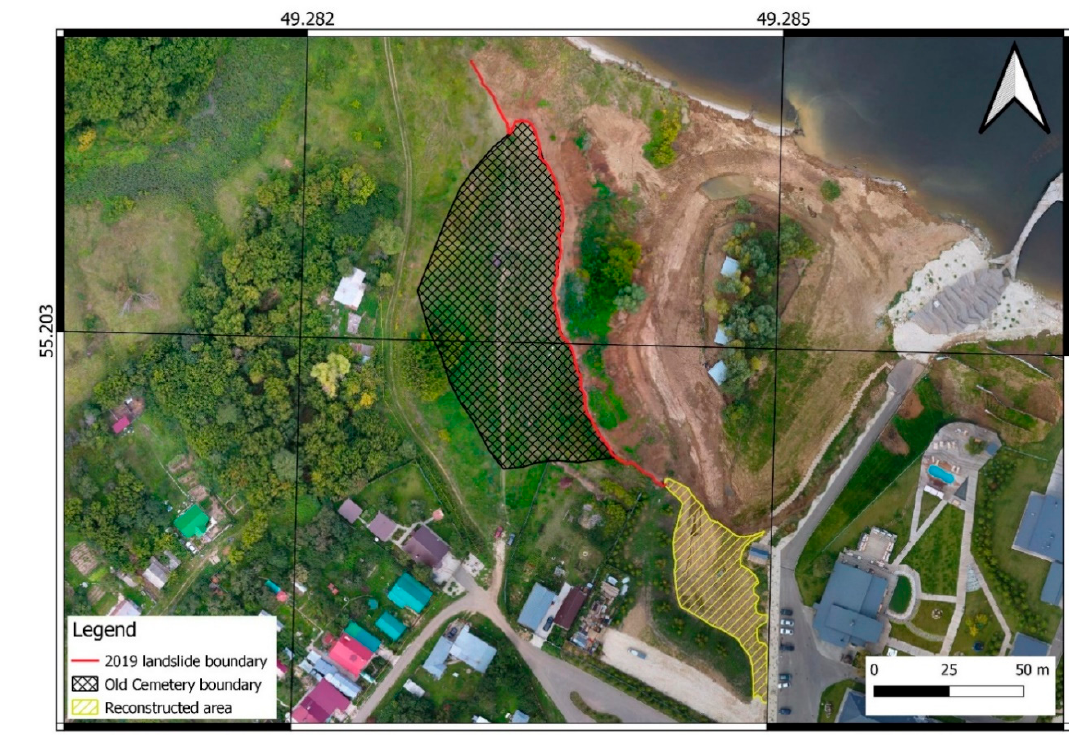
Figure 3. Aerial view (2019) of Site 2 with landslide polygon.